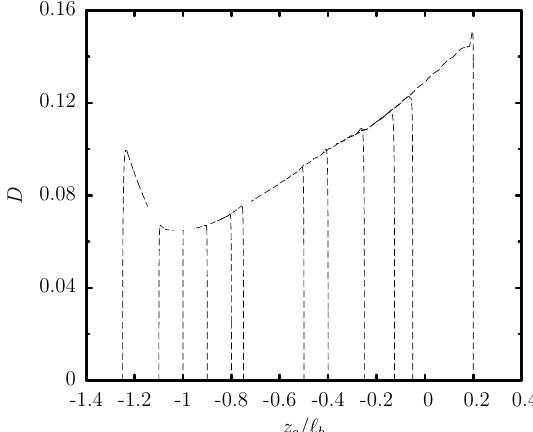
Figure 5. Evolution of the deformation D as a function of the centroid z c , for a capsule with a / (cid:96) b = 0.55, Ca = 0.1 and different initial positions z 0 c / (cid:96) b in the range [ with (cid:96) z / (cid:96) b = 2 and (cid:96) a / (cid:96) b = 0.25. Note that D = ( L and minimum distance of the capsule membrane from its centroid x c